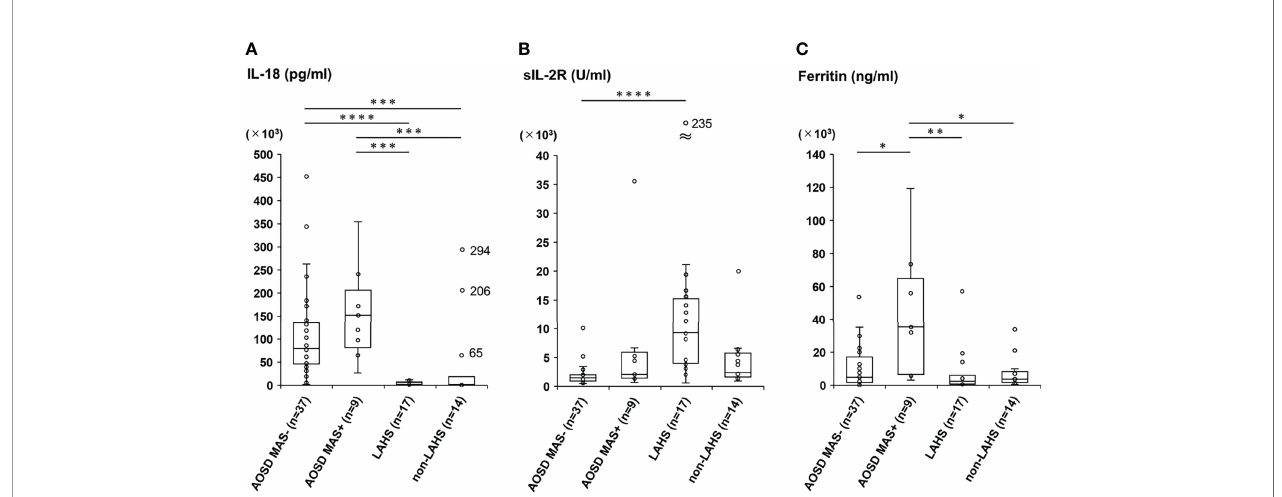
FIGURE 1 | Comparisons of serum levels of IL-18, sIL-2R, and ferritin between the AOSD and adult HLH groups with different subtypes. Serum levels of IL-18 (A) , sIL-2R (B) , and ferritin (C) were compared among patients with AOSD without MAS (AOSD MAS − ), those with AOSD with MAS (AOSD MAS+), patients with LAHS, and a non-LAHS group. N corresponds to the number of samples assayed in each group. The Kruskal-Wallis test followed by post hoc Dunn ’ s test with Bonferroni correction was used to compare the four groups; *p<0.05, **p < 0.01, ***p < 0.001, ****p < 0.0001. MAS, macrophage activation syndrome; LAHS, lymphomas- related hemophagocytic syndrome. In panel (A) , very high serum IL-18 levels in three patients of the non-LAHS group are indicated by a real number beside the dot (unknown; 294,000 pg/mL, breast cancer with systemic metastasis; 206,000 pg/mL, multiple muscle abscesses; 648,56 pg/mL). In panel (B) , a remarkably elevated serum sIL-2R level (235,320 U/mL) in one patient of the LAHS group is indicated by a real number beside the dot.